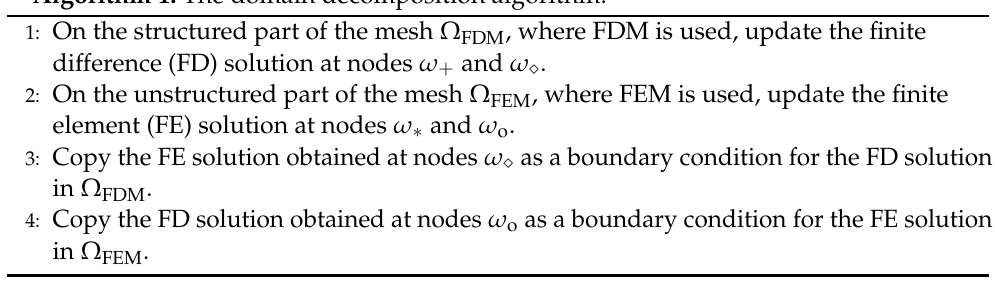
Algorithm 1: The domain decomposition